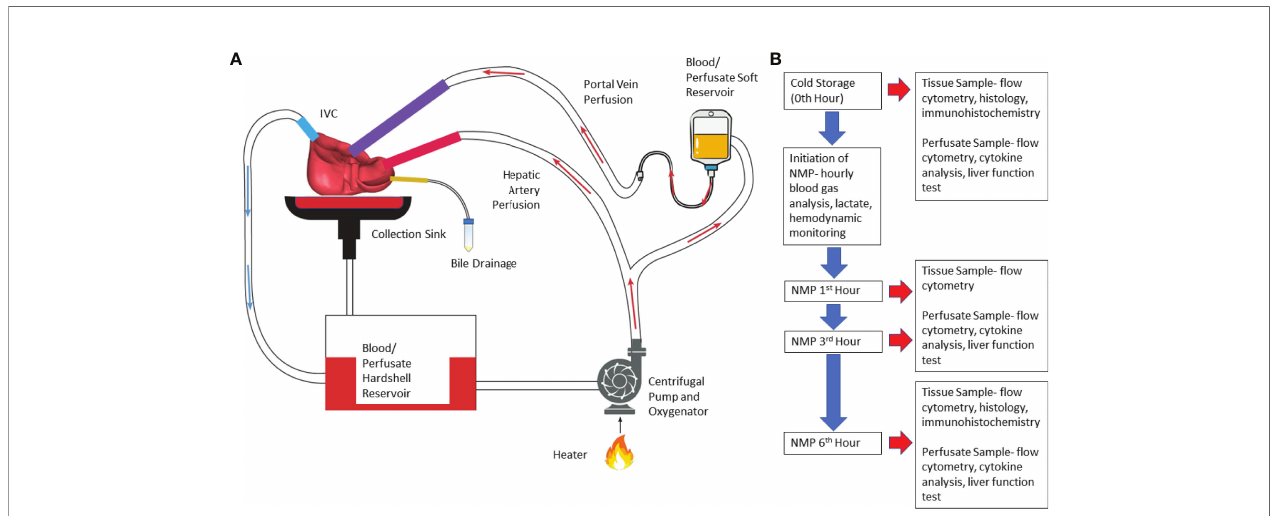
FIGURE 1 | Illustration of normothermic machine perfusion set up and experimental design. (A) Schematic illustration- Perfusion of the circuit is propelled by a centrifugal pump; the perfusate passes through the heater and oxygenator where the perfusate is oxygenated by sweep gas that contains high concentration of O 2 and low concentration of CO 2 ; ef fl uent perfusate from hepatic vein drains directly into the cannula which routes the perfusate to venous reservoir. (B) Experimental Design- Timeline of perfusion and sample collection. (NMP, normothermic machine